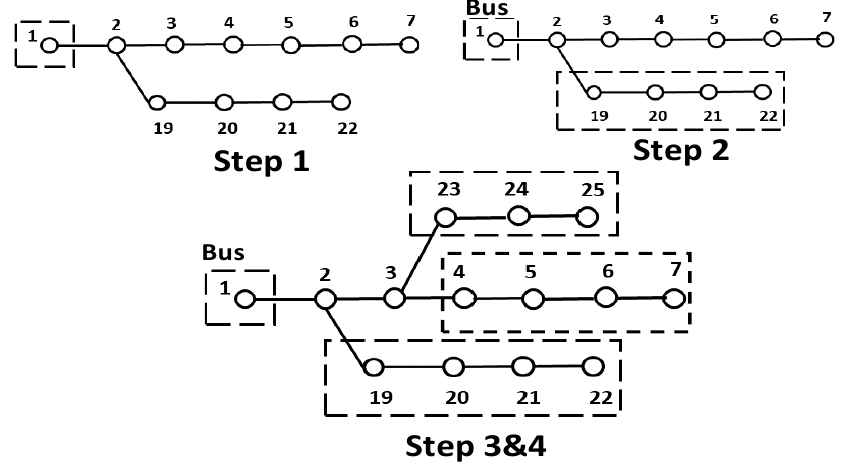
Figure 3. Steps involved in the proposed Graph Search Method.